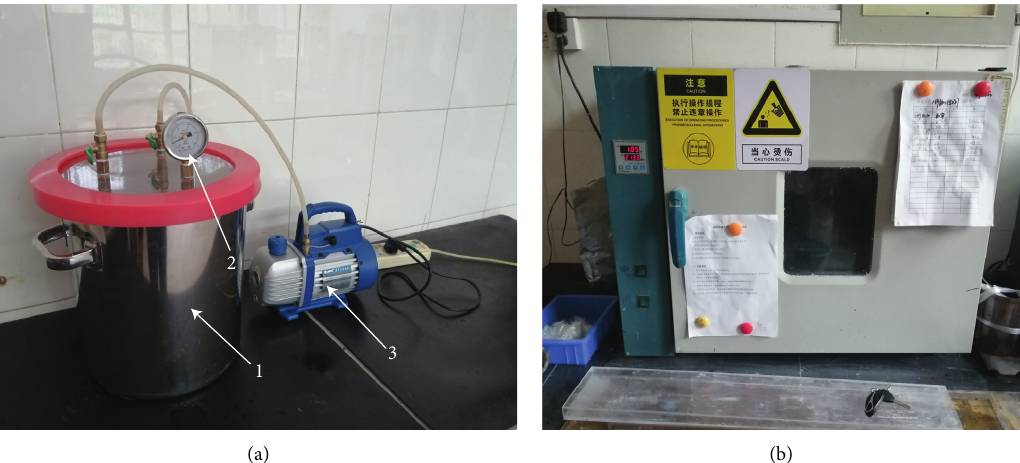
Figure 4: Saturation and drying device. (a) Vacuum saturator. (b) Drying box. 1- Saturating cylinder. 2- Vacuum pressure gauge. 3-Vacuum pump